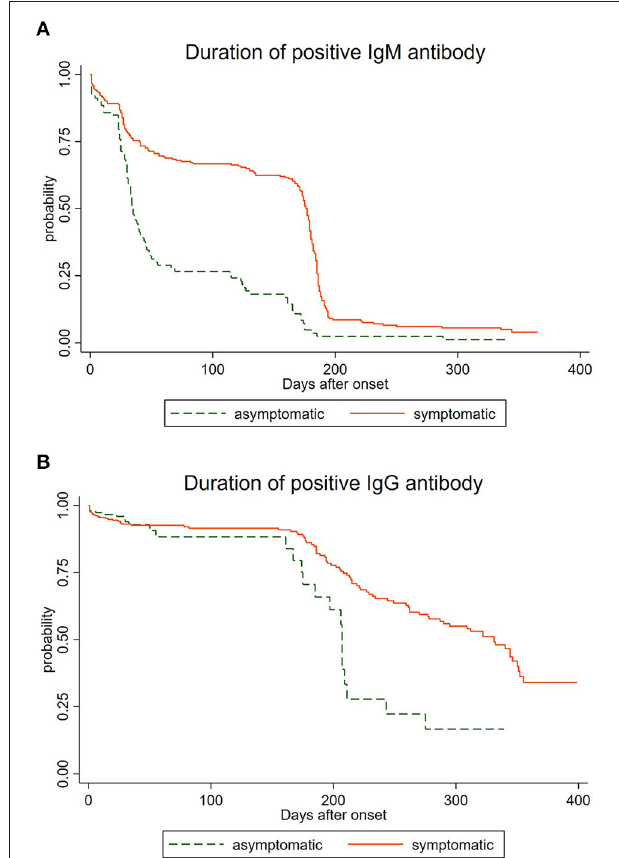
FIGURE 1 | Duration of IgM and IgG antibodies among asymptomatic and symptomatic cases. (A) Duration of IgM antibodies among asymptomatic and symptomatic cases. (B) Duration of IgG antibodies among asymptomatic and symptomatic cases.